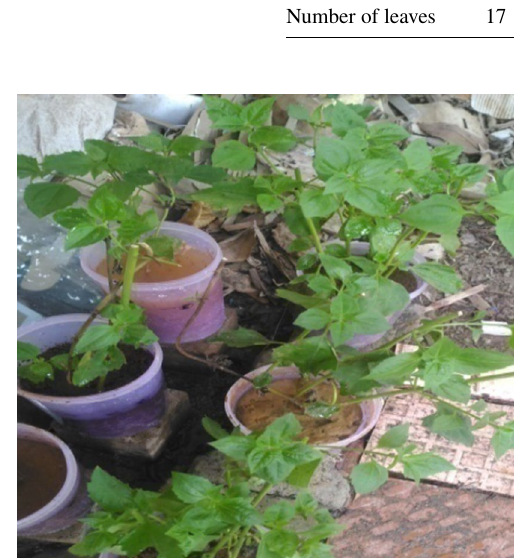
Fig. 6 Growth of plants with oil